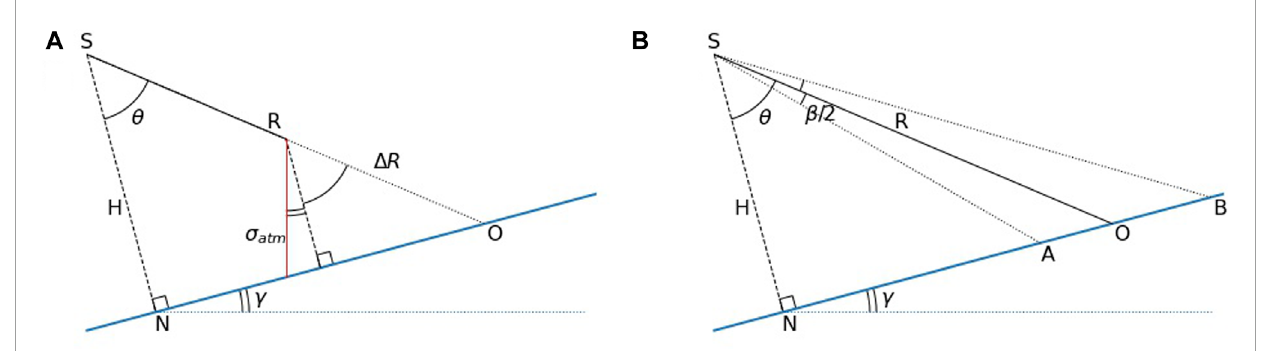
FIGURE 5 Geometry of the laser beam from the TLS at S to a point at the surface O with distance R . The blue line is a plane through O with H being a normal on this plane. (A) Change in the distance of the laser beam from S to O , Δ R , is calculated from the LES (Sect. 3.4). The extent of σ atm is calculated with slope γ and incidence angle θ . (B) AB is the major axis of the elliptical footprint, θ the incidence angle, and β the beam